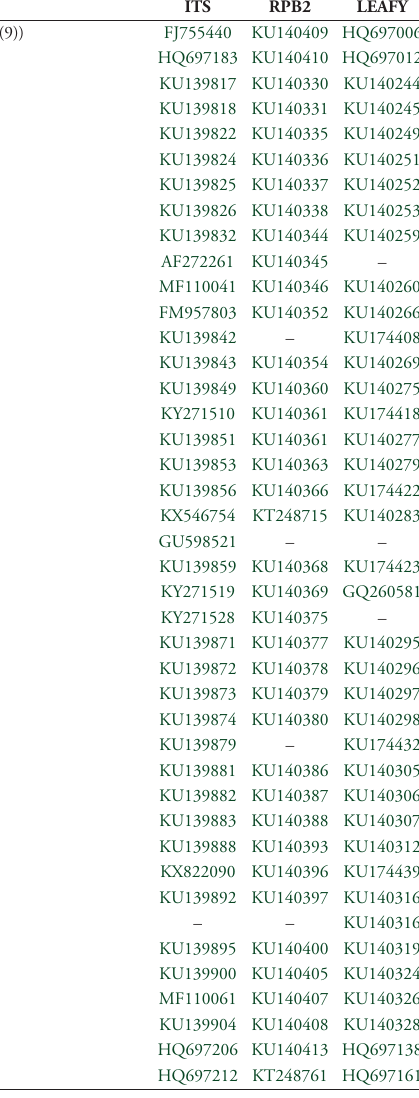
Table 2. Sequences obtained from the GenBank for phylogeny of Asian Cinnamomum . Taxon ITS